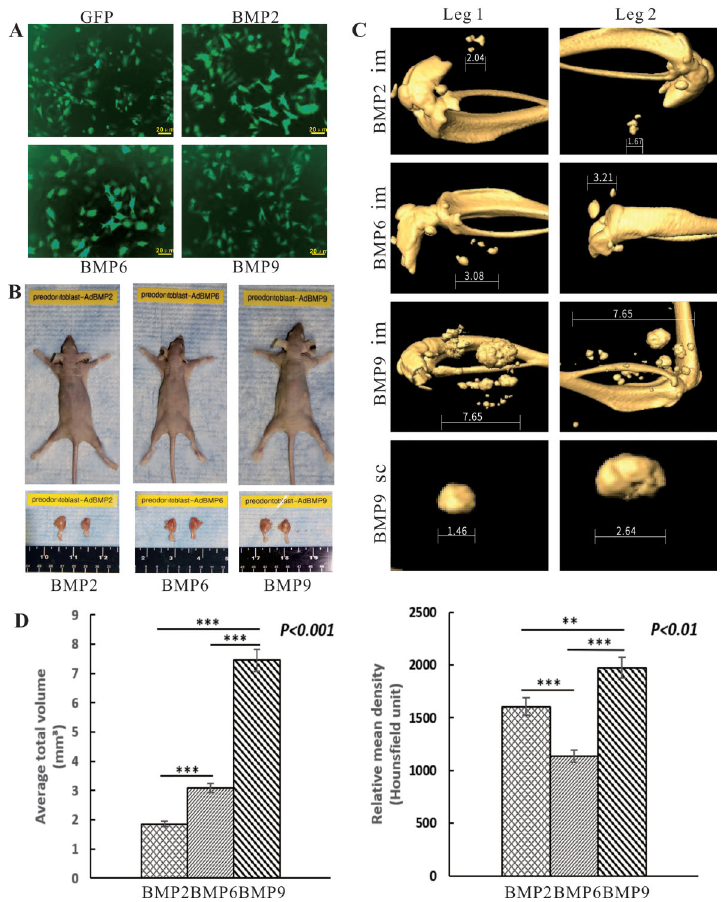
Figure 5. Bone morphogenetic proteins (BMPs) effectively induced osteogenesis of immortalized preodontoblasts (iPDBs) in vivo . Subcon fl uent iPDBs were equally infected with Ad-BMP2, 6, 9, or Ad-GFP ( A ; scale bars 20 m m), collected and resuspended in PBS for subcutaneous (sc) injections into the fl anks, or intramuscular (im) injections [10 6 cells/site in 100 mL PBS] of athymic nude mice. At 6 weeks after implantation, masses formed at the injection sites were retrieved ( B ), fi xed in formalin, and subjected to m -CT imaging. No detectable masses were formed in the Ad-GFP infected and subcutaneous BMP2 and 6 infected iPDBs groups. Representative 3-D isosurface reconstruction images of the retrieved masses are shown ( C ). The mean (SD) volume and density of masses were quantitatively analyzed ( D ). **P o 0.01, ***P o 0.001 (ANOVA). GFP: green fl uorescent